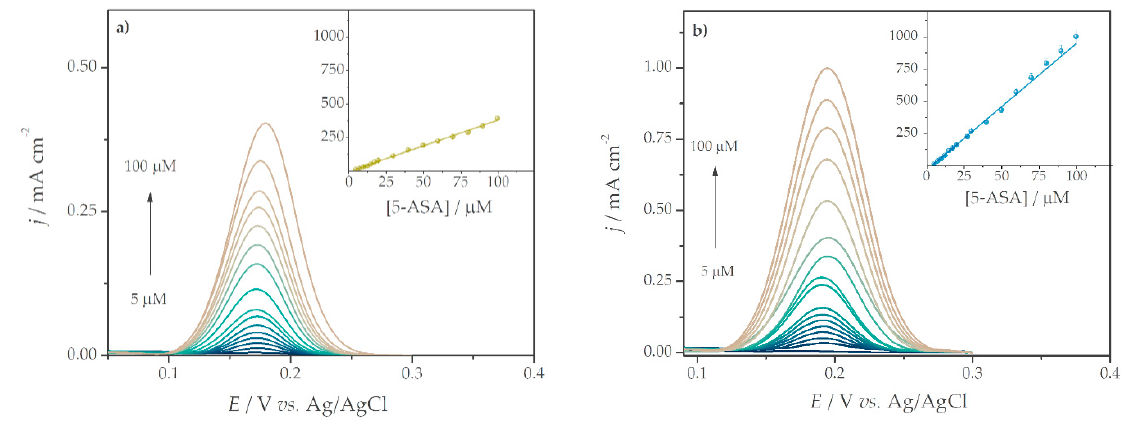
Figure 5. DPVs ( v = 4 mV s − 1 , step potential 2 mV, pulse amplitude 50 mV) with ( a ) PMB DES /CNT/GCE and ( b ) CNT/PMB DES /GCE in 0.04 M BR buffer solution pH 7.0 for 5.0, 7.5, 10.0, 12.5, 15.0, 17.5, 20.0, 22.5, 25, 27.5, 30.0, 40.0, 50.0, 60.0, 70.0, 80.0, 90.0, and 100.0 µM 5-ASA. Inset, corresponding calibration plots.